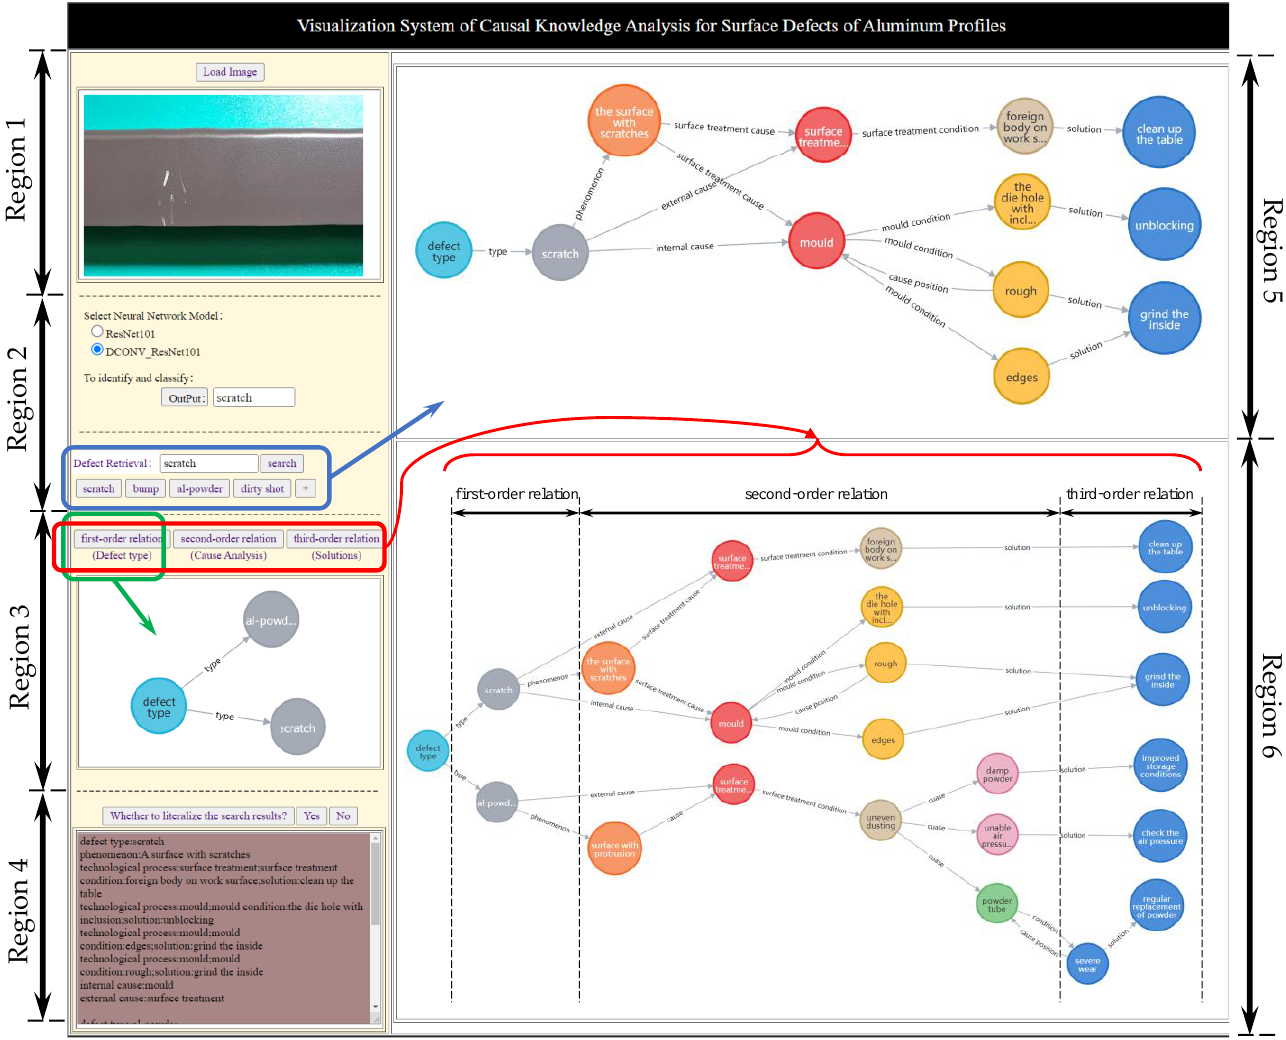
Figure 17. Diagnosis system for classification and formation mechanism analysis of product surface defects.